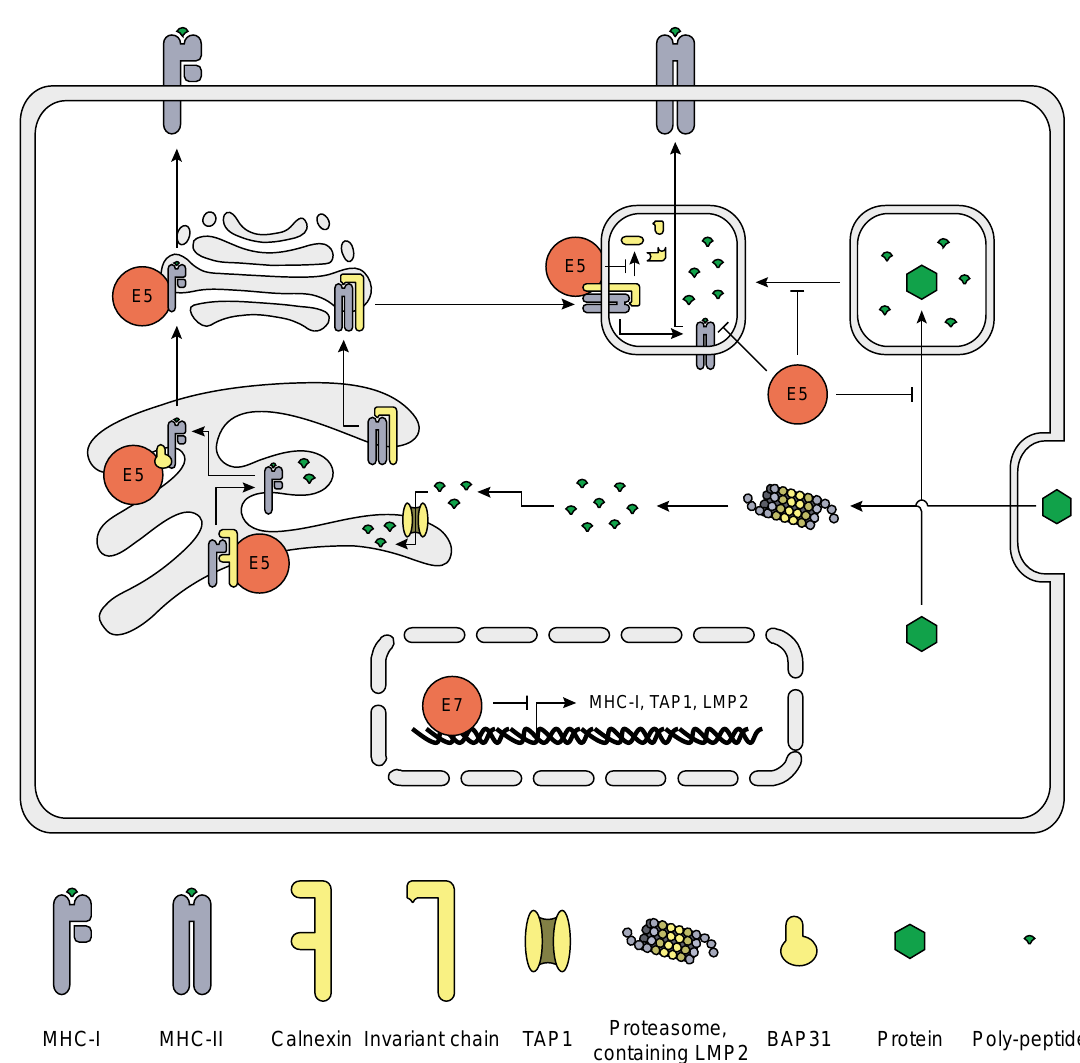
Figure 4. Schematic representation of the effects of hrHPV on antigen presentation. The proteasome processes proteins into peptides, which are transported into the ER via TAP1. Aided by several chaperone proteins, MHC-I is folded and loaded with peptide after which it exits the ER to travel via the Golgi apparatus to the plasma membrane were the peptides are presented to T cells. HPV proteins (red) attenuate gene expression of critical components of this pathway, as well as actively retains MHC-I in the ER and Golgi apparatus. MHC-II forms in the ER and complexes with the invariant chain. The complex travels via the ER and Golgi apparatus to lysosomes where the invariant chain is degraded and MHC-II is loaded with processed peptides from endocytosed proteins. Loaded MHC-II then travels to the plasma membrane to present the peptides. Upon IFN γ stimulation, HPV E5 (red) blocks invariant chain degradation and peptide loading, as well as inhibits endosome acidification and maturation.